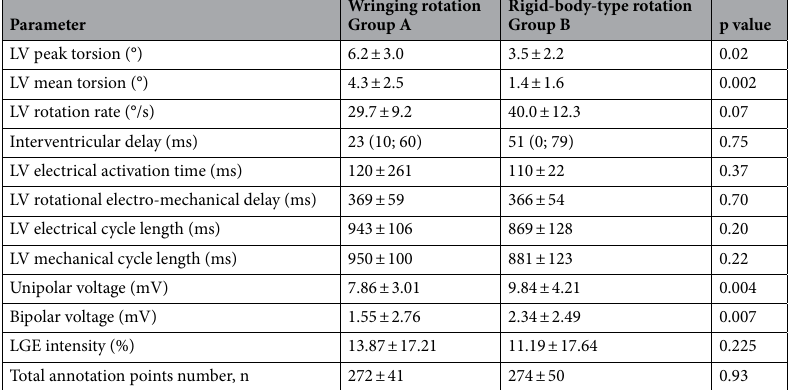
Table 2. Global rotational and electro-mechanical parameters of LV. Values are mean ± SD or median (25th; 75th percentile). LGE late gadolinium enhancement, LV left